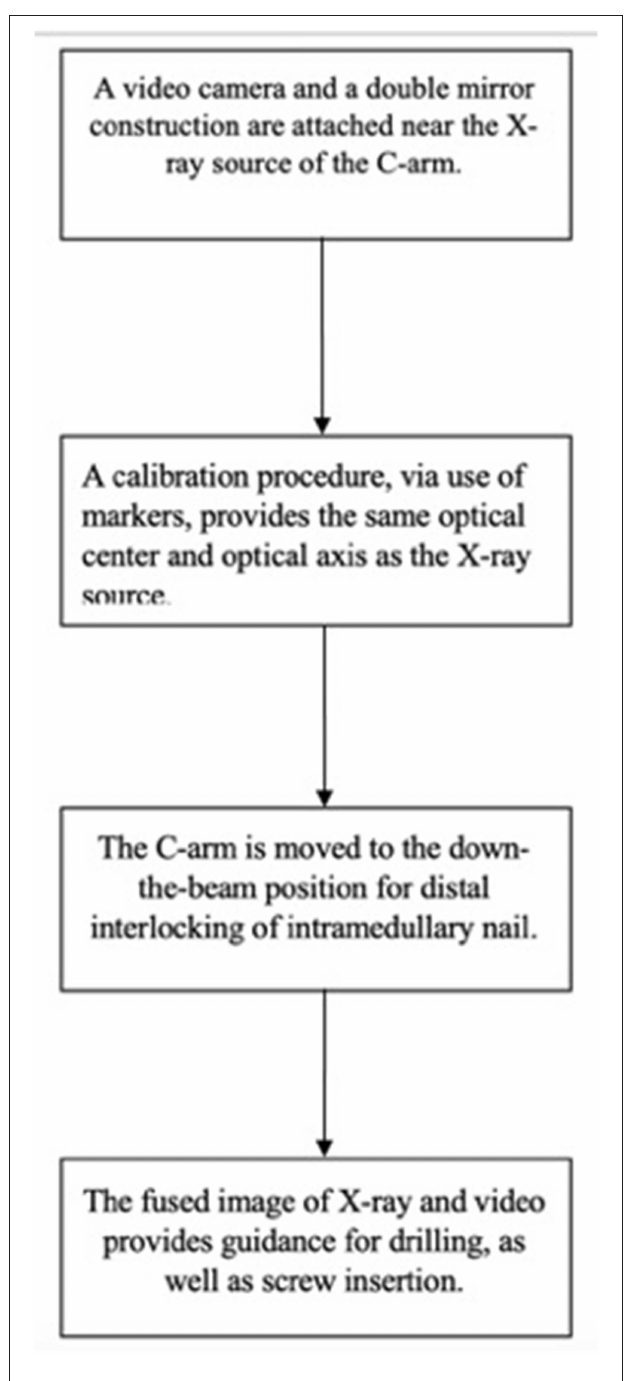
FIGURE 2 | A diagram which depicts the use of a camera-augmented C-arm for distal interlocking of an intramedullary nail.